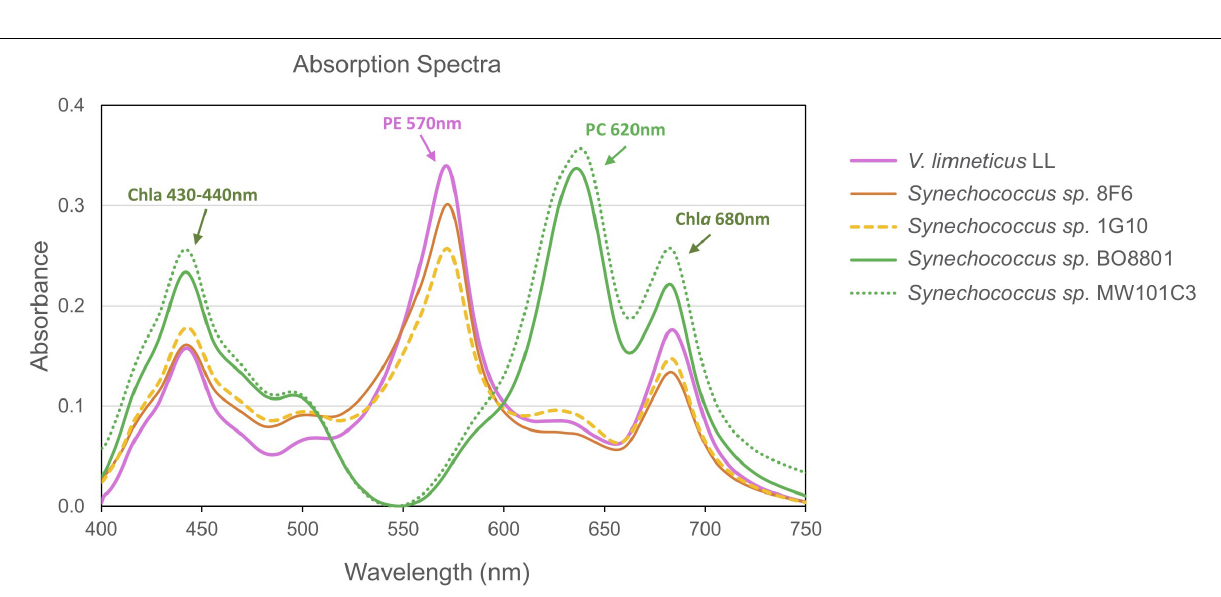
Frontiers in Microbiology |